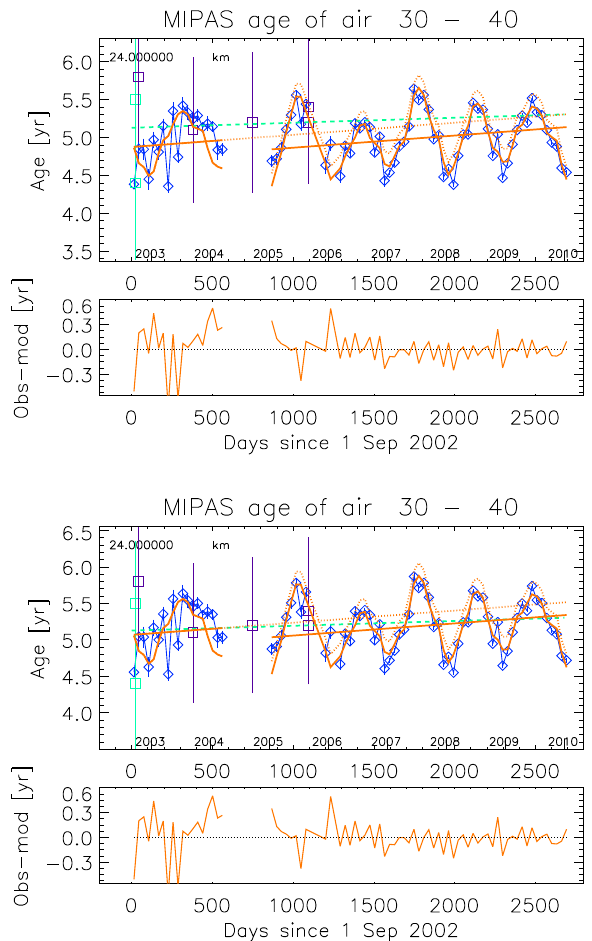
Fig. 8. Temporal evolution of mean age of air for 30 ◦ N to 40 ◦ N, 24km with correction of ”over-aging” (top) and without (bottom). The linear increase in the top panel is 0.59 yrdecade − 1 , compared to 0.61 yrdecade − 1 without ”over-aging”-correction. The green dashed line is the 30-yr trend derived by Engel et al. (2009), and the green and violet squares are the data points and their uncertainties of the Engel et al. (2009) study which fall into the observation period of MIPAS.